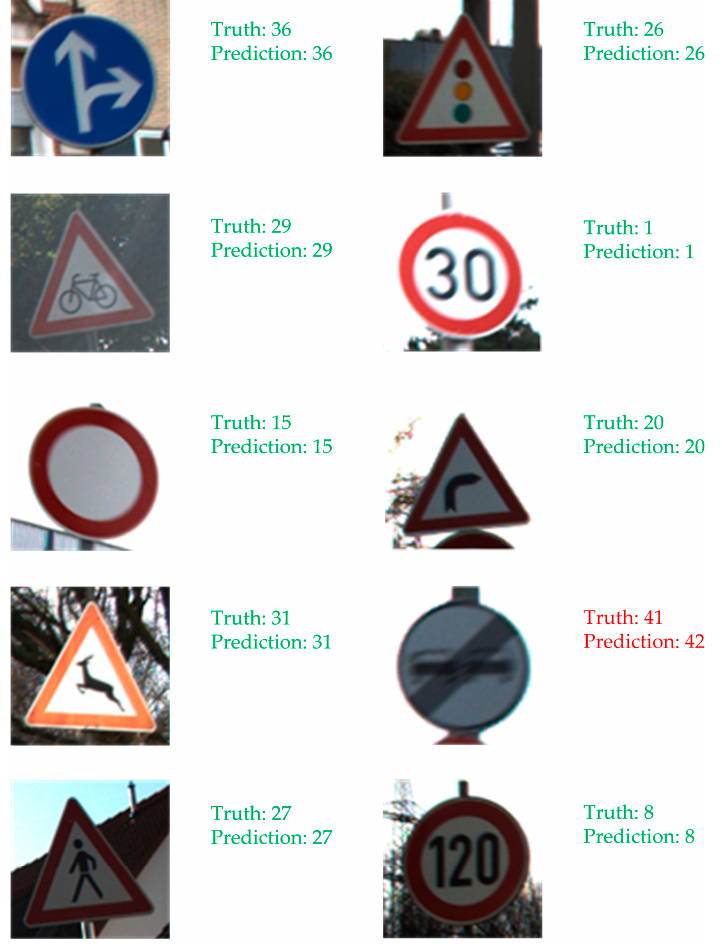
Figure 11. The classification prediction results of some sample images in the network training stage.